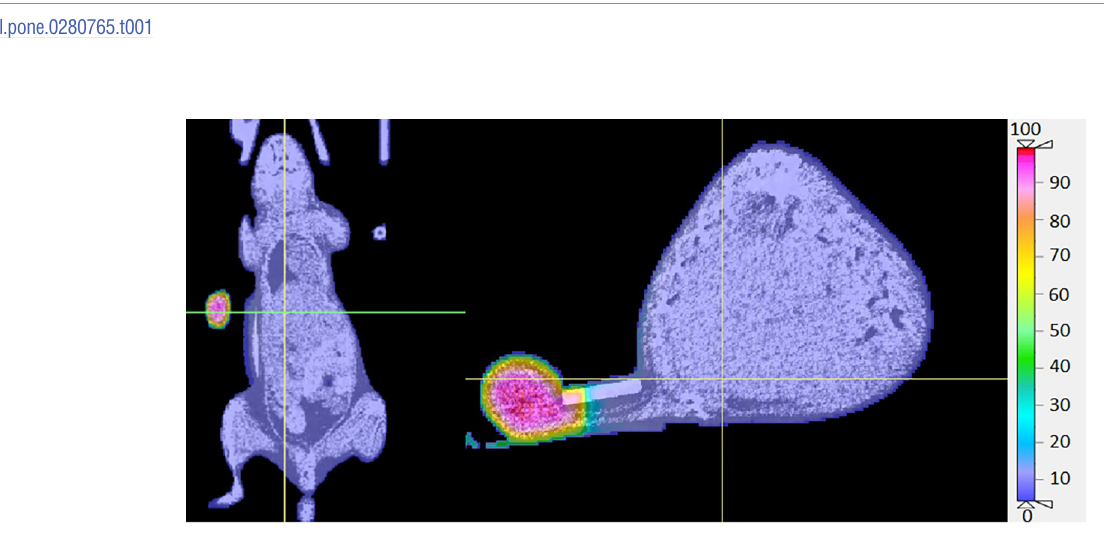
Dose values for all points of the calculated profile along with the corresponding measured doses (normalized to their respective maximum doses). Dose calculation errors are presented in the last column.